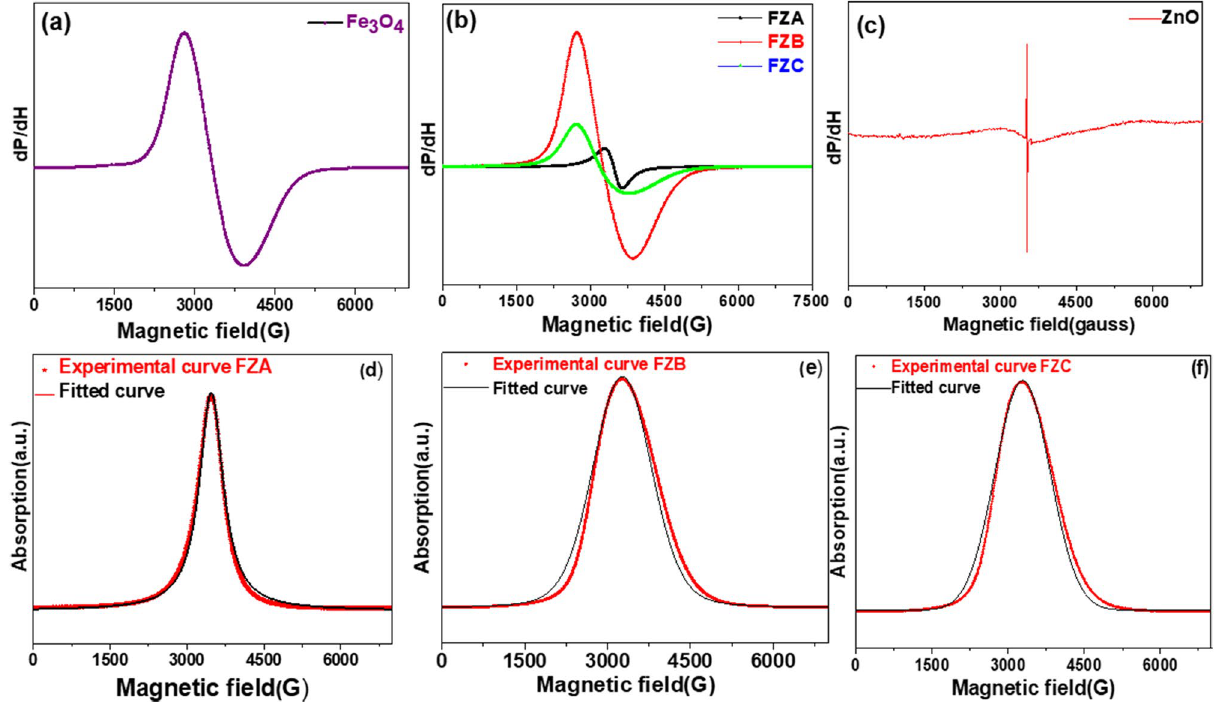
Figure 7. Room temperature FMR spectra of samples ( a ) FN, ( b ) FZNC, ( c ) ZN ( d – f ) fitted data of FZNC sample ( d ) FZA, ( e ) FZB, ( f )